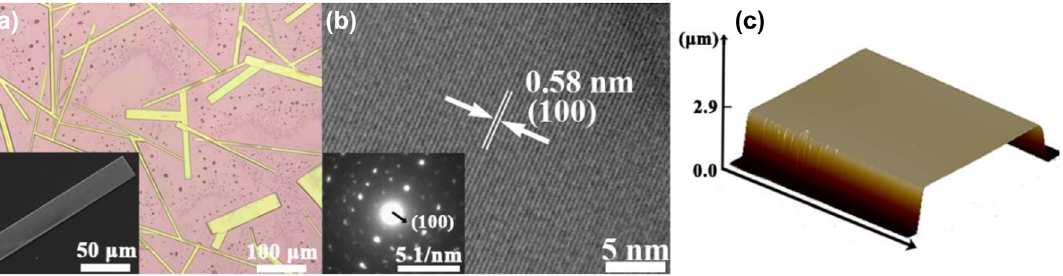
Figure 1: Microstructure images of CsPbBr MW. Inset: SAED pattern. (c) 3D AFM diagrams of single CsPbBr of CsPbBr 3